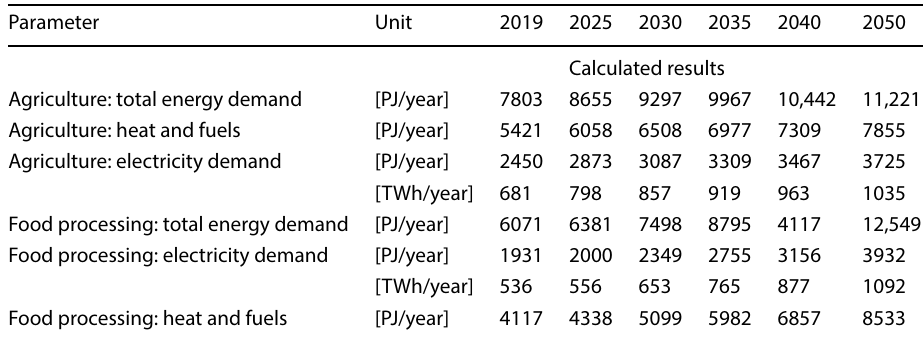
Table 6 Results -energy demand for agriculture and food